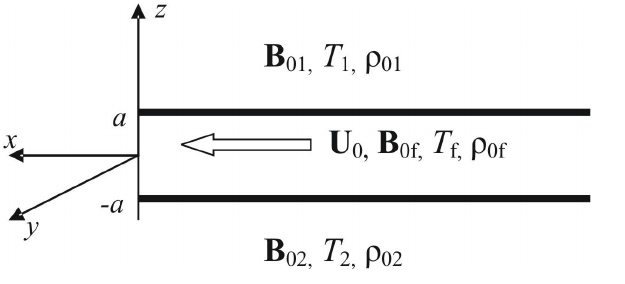
Fig. 12. Geometry of the three-layer model.